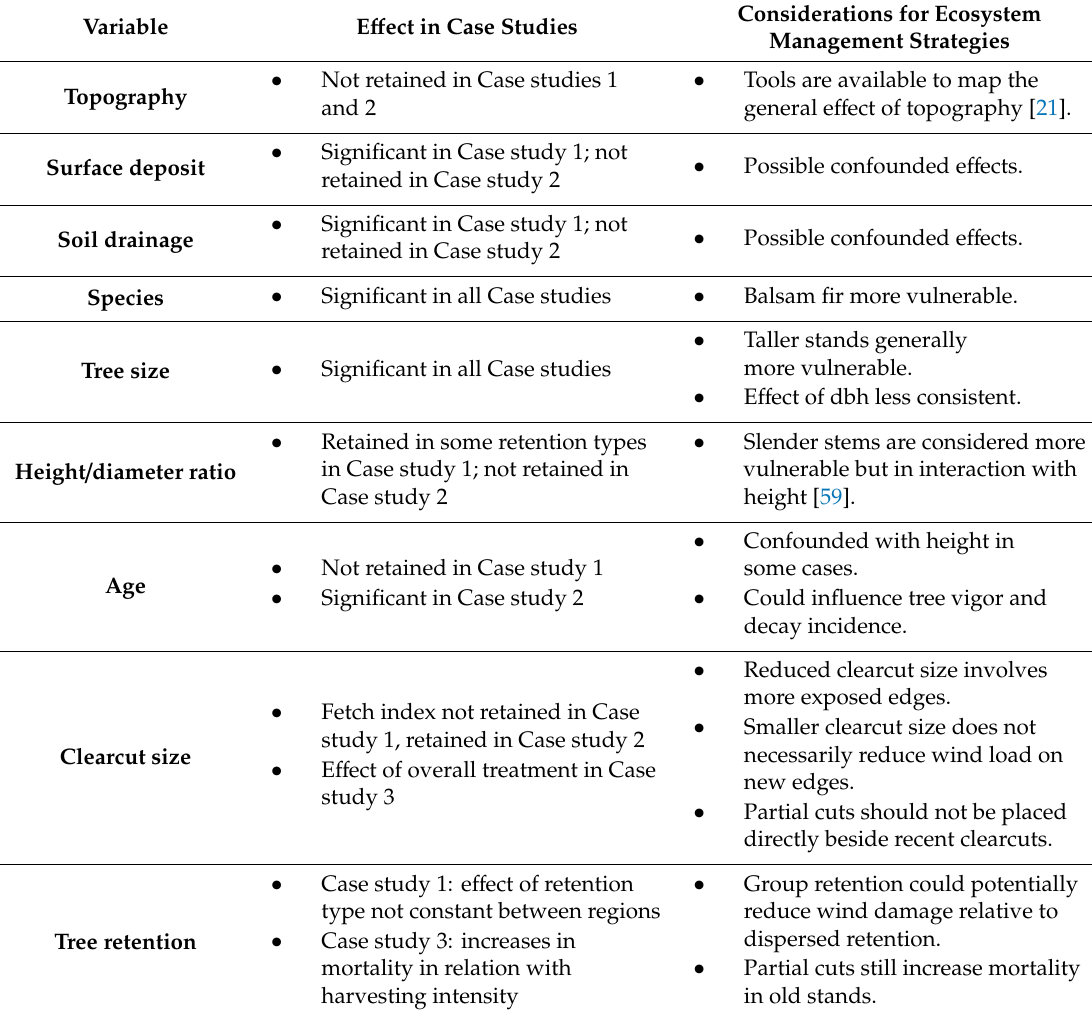
Table 3. Synthesis of variable e ff ects in the three case studies and related considerations for the design of forest ecosystem management strategies. Significance of e ff ects is mentioned for case studies where it was